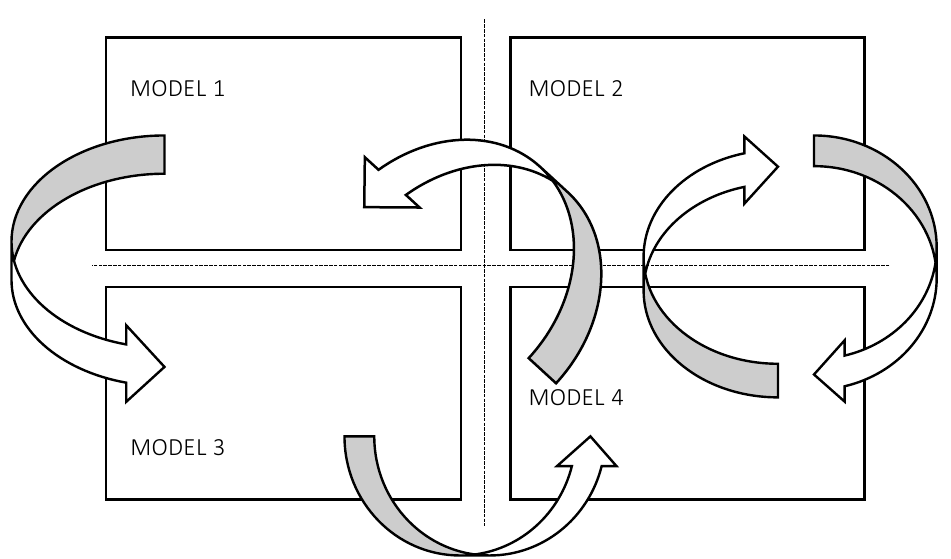
Figure 5. Synergy of prognostic ways of developing innovative models